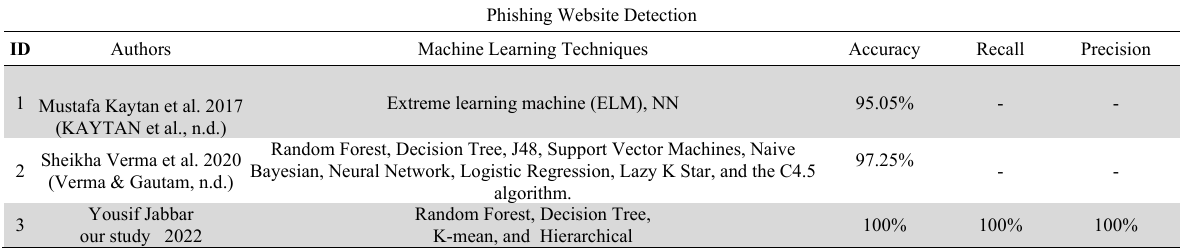
Comparing the results of our study with the results of previous studies using the same